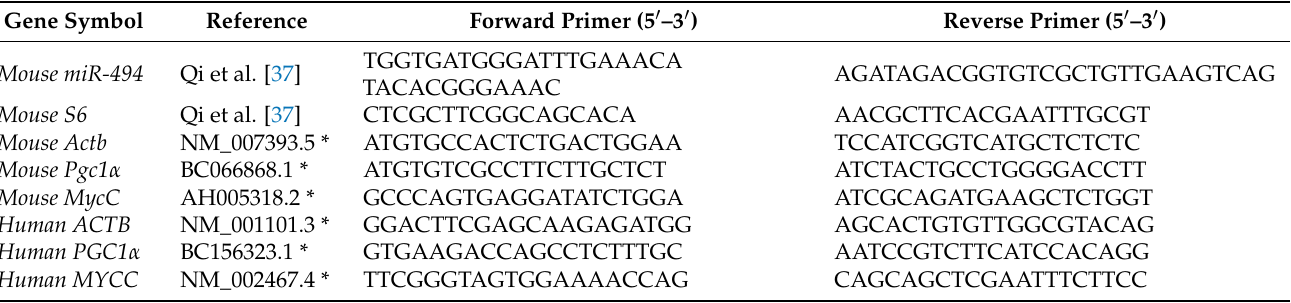
Table 2. Primer pairs used in this